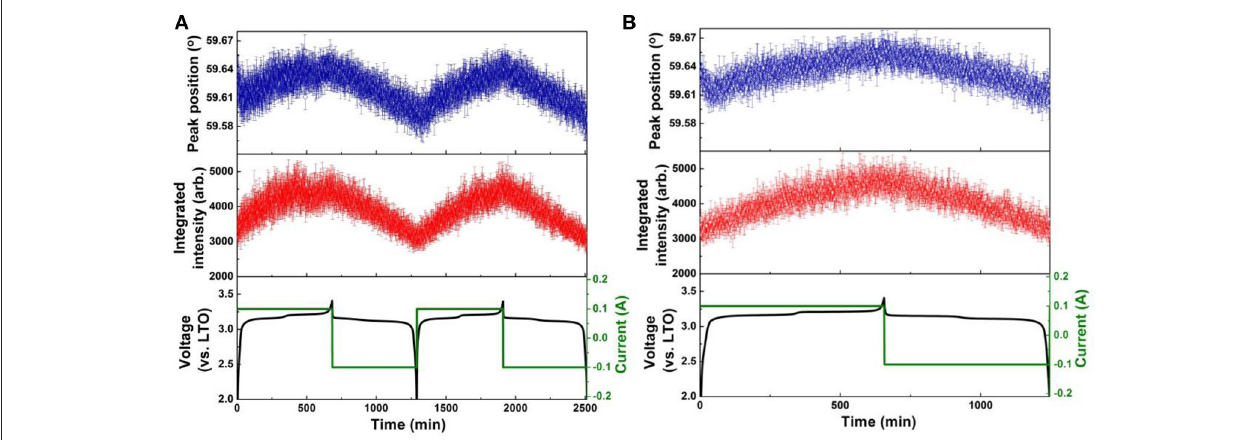
FIGURE 5 | Results of single peak fitting of the LTO 222 reflection in NPD data of the LNMO||LTO battery, including peak position and intensity for (A) the first two cycles, and (B) the 51st cycle. Battery voltage and current are shown alongside.